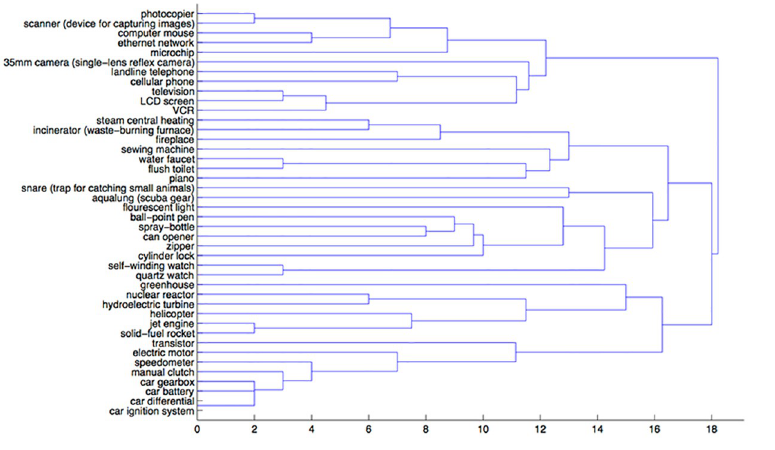
Fig 3. A dendrogram representing the general condition sortings.